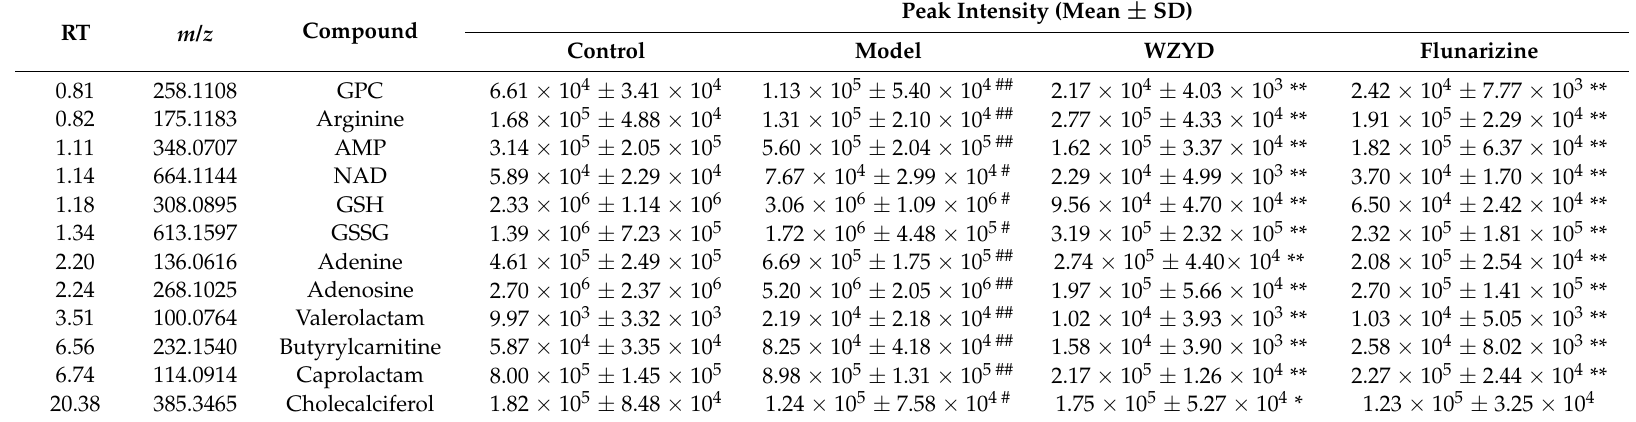
Table 1. Potential brain homogenates biomarkers detected by liquid chromatography-high resolution mass spectrometry (LC-HRMS) and their intensities in control, model, WZYD and flunarizine groups analyzed by one-way ANOVA.